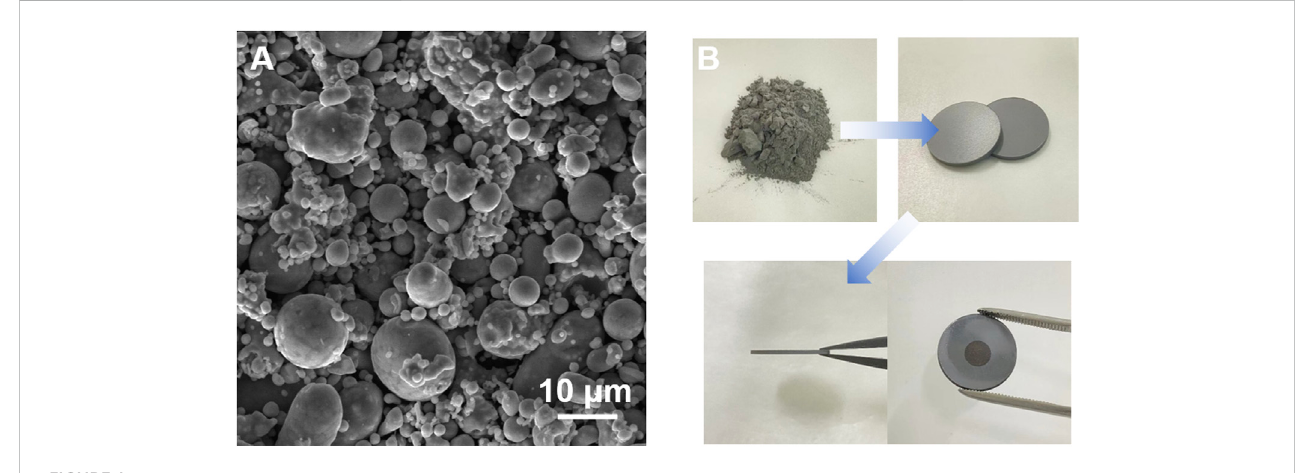
FIGURE 1 SEM image showing the as-received SS430L powder (A) and photographs showing the brief summary of the cell fabrication process (B)